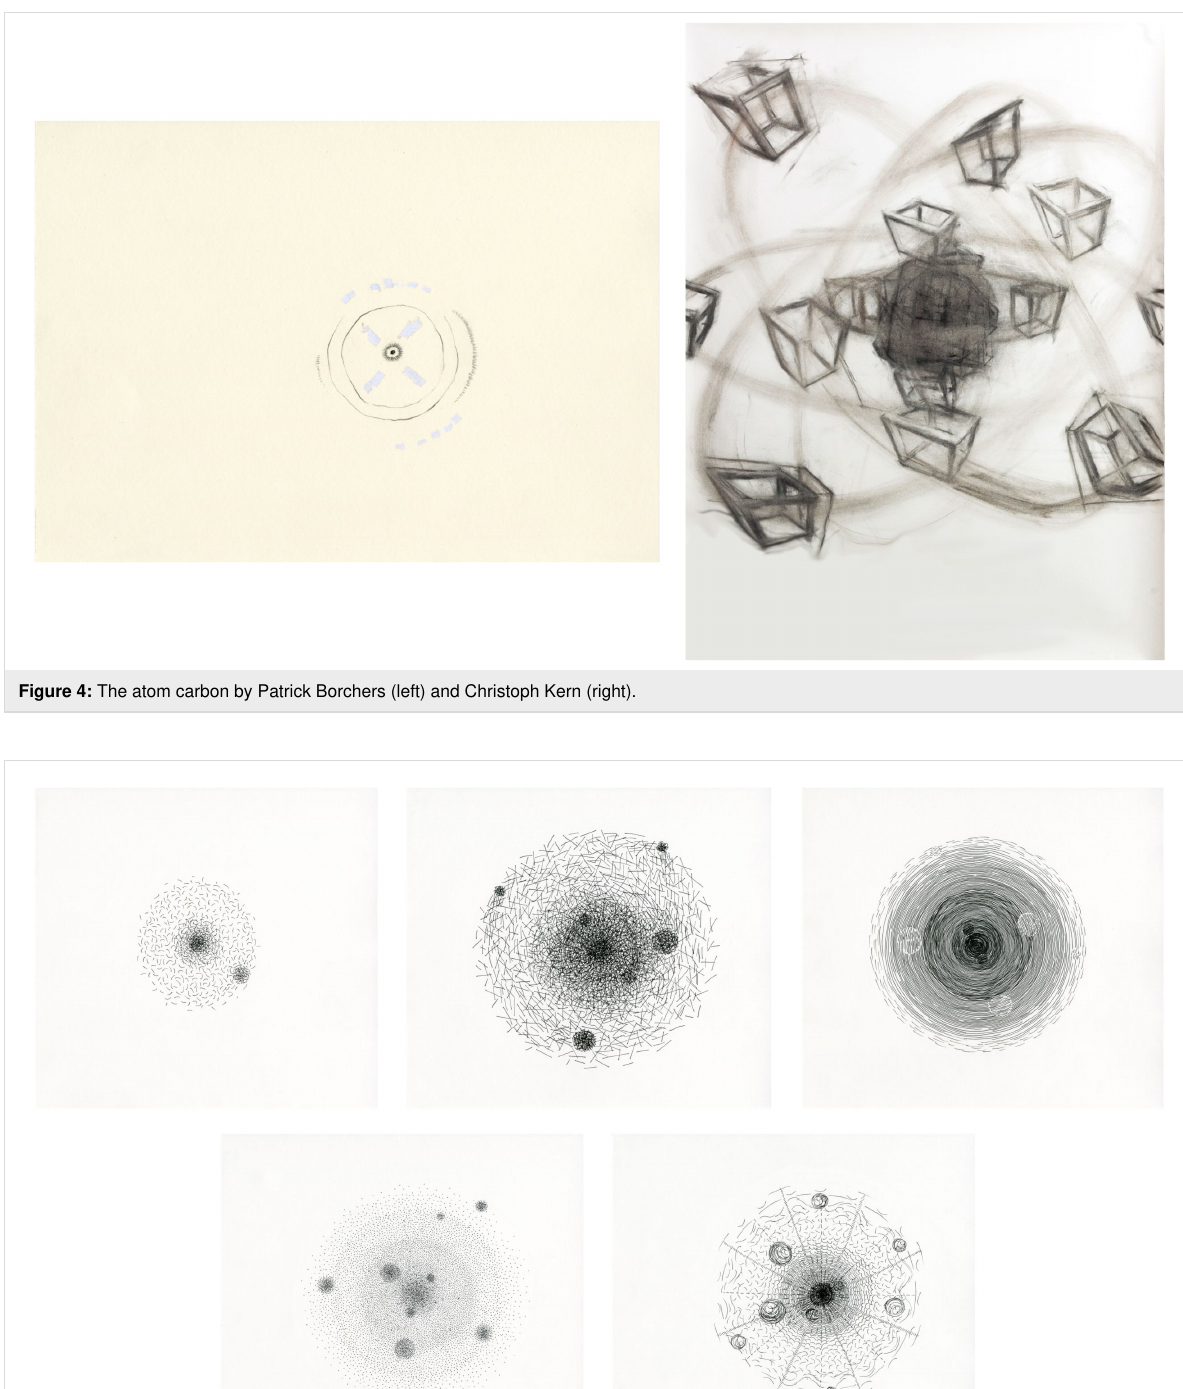
recognized to be non-perspective isomorphic to the other